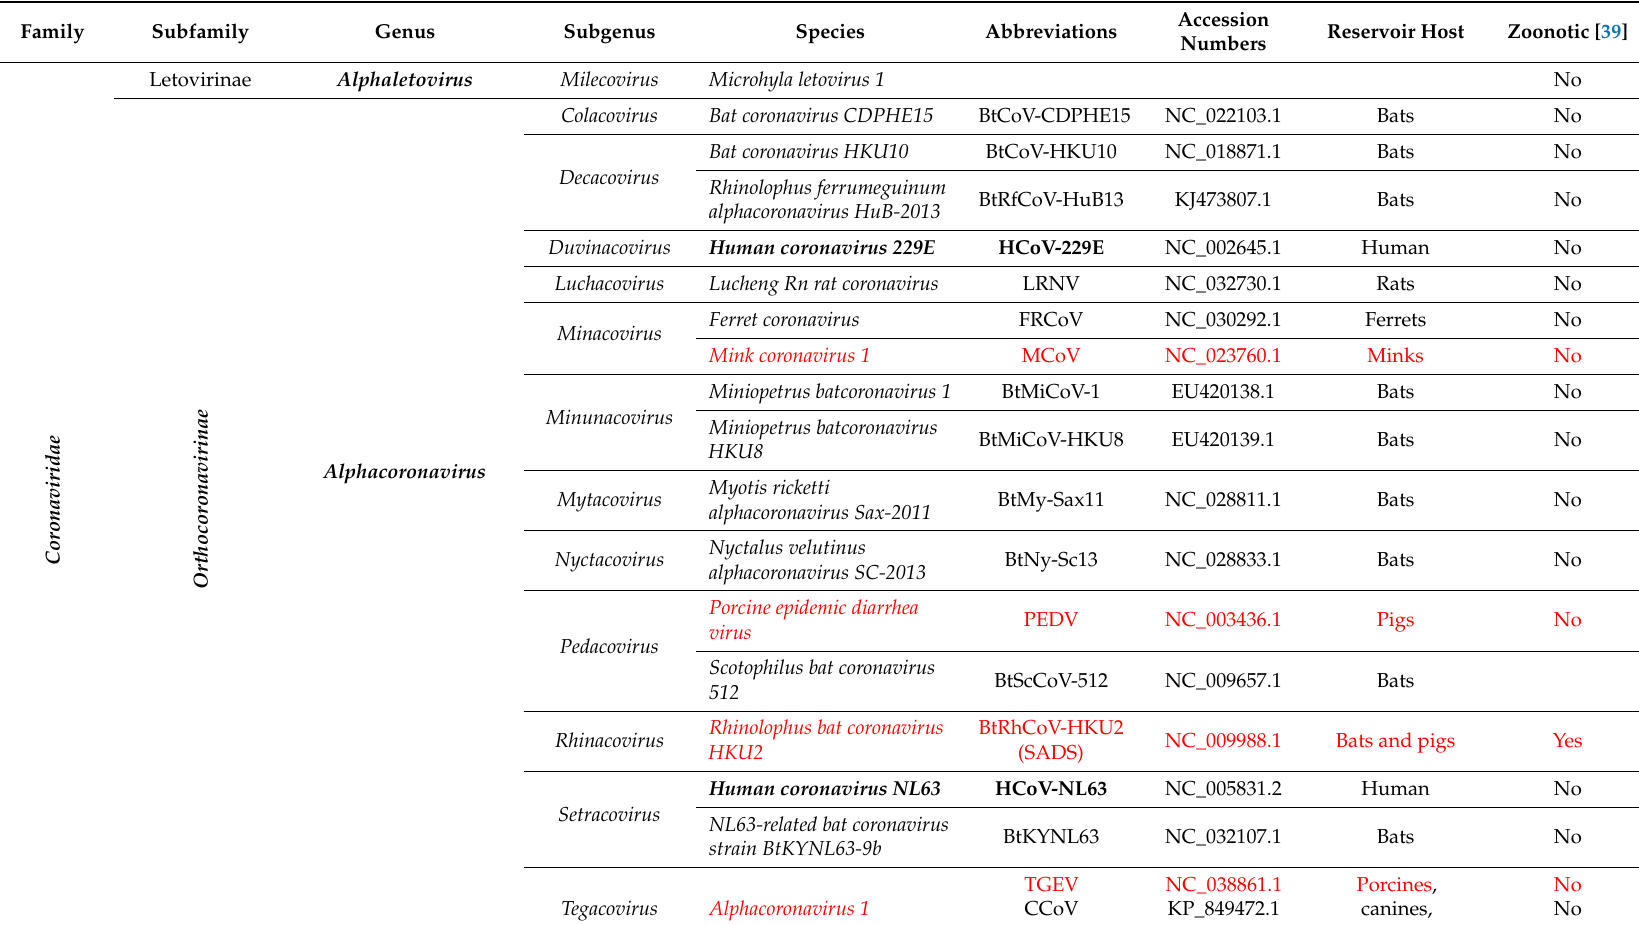
Table 1. Classification of Coronaviridae according to the International Committee of Taxonomy of Viruses (ICTV), with special emphasis on reservoir host, zoonotic importance, and major